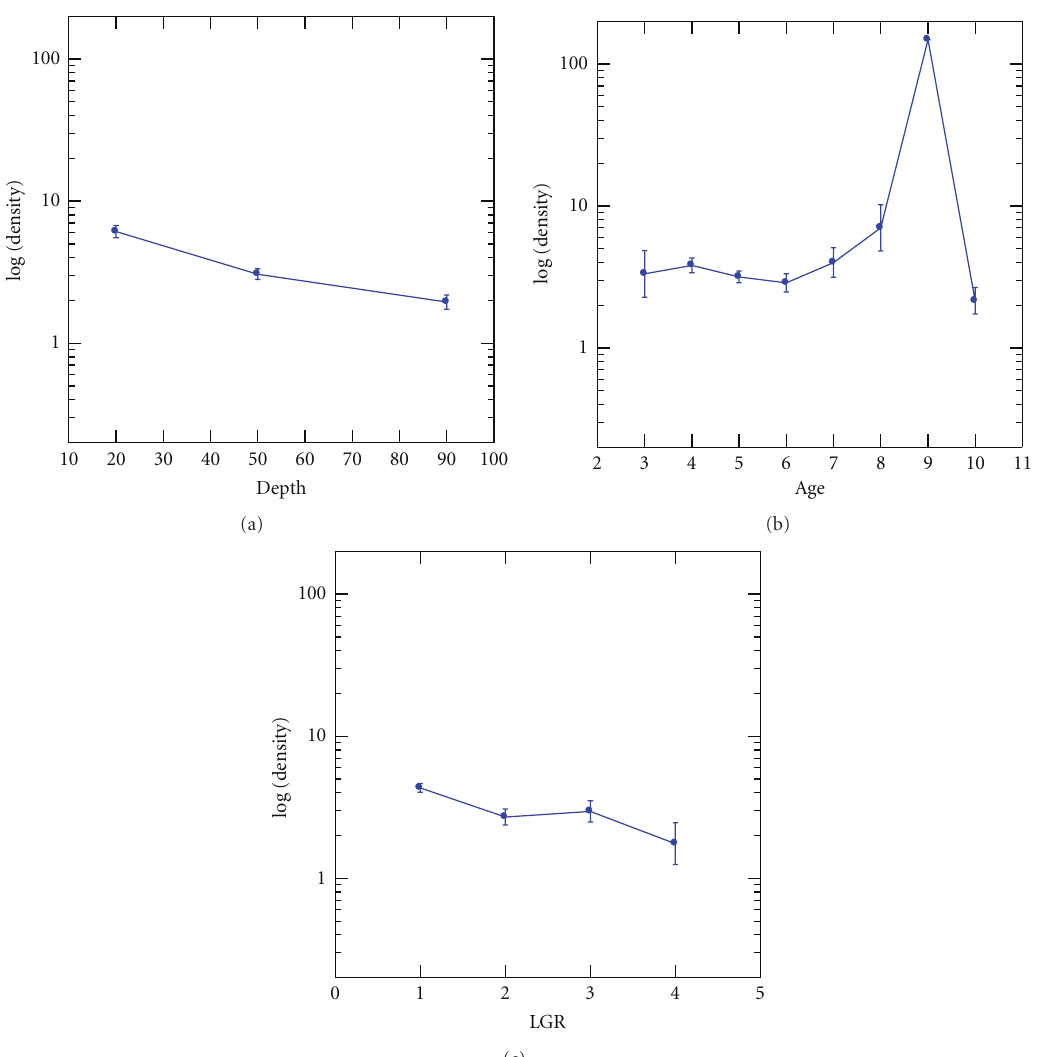
Figure 4: Density (logarithmic scale) of sealworm larvae ( Pseudoterranova sp. (p)) in cod ( Gadus morhua ) in relation to length groups of fish ((1) 40–54 cm, (2) 55–59 cm, (3) 60–69 cm and (4) > 70cm), fish-age, and sea-water